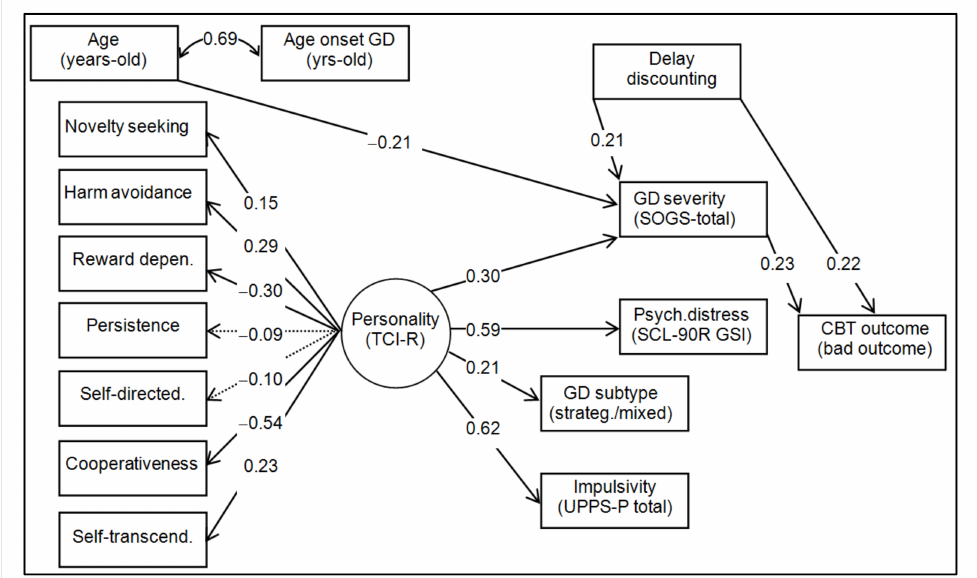
Figure 1. Path-diagram: standardized coefficients. Note. Bad outcome: dropout or relapse. Sample size: n =